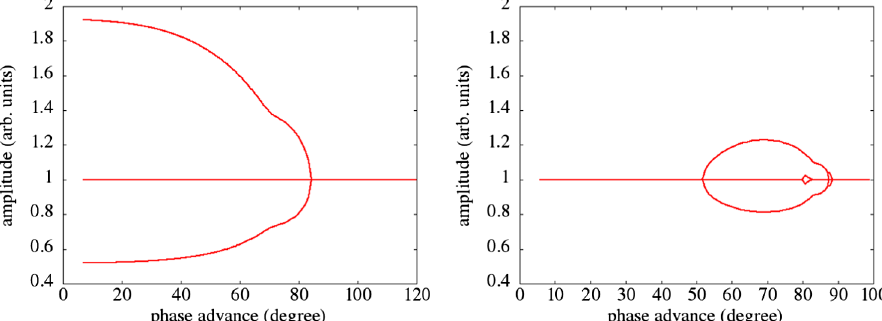
FIG. 9. The 3D envelope mode growth rate amplitudes as a function of depressed transverse phase advance with 120 zero current transverse and longitudinal phase advances in a periodic quadrupole-rf channel without acceleration (left) and with 8 MV = m accelerating gradient (right).